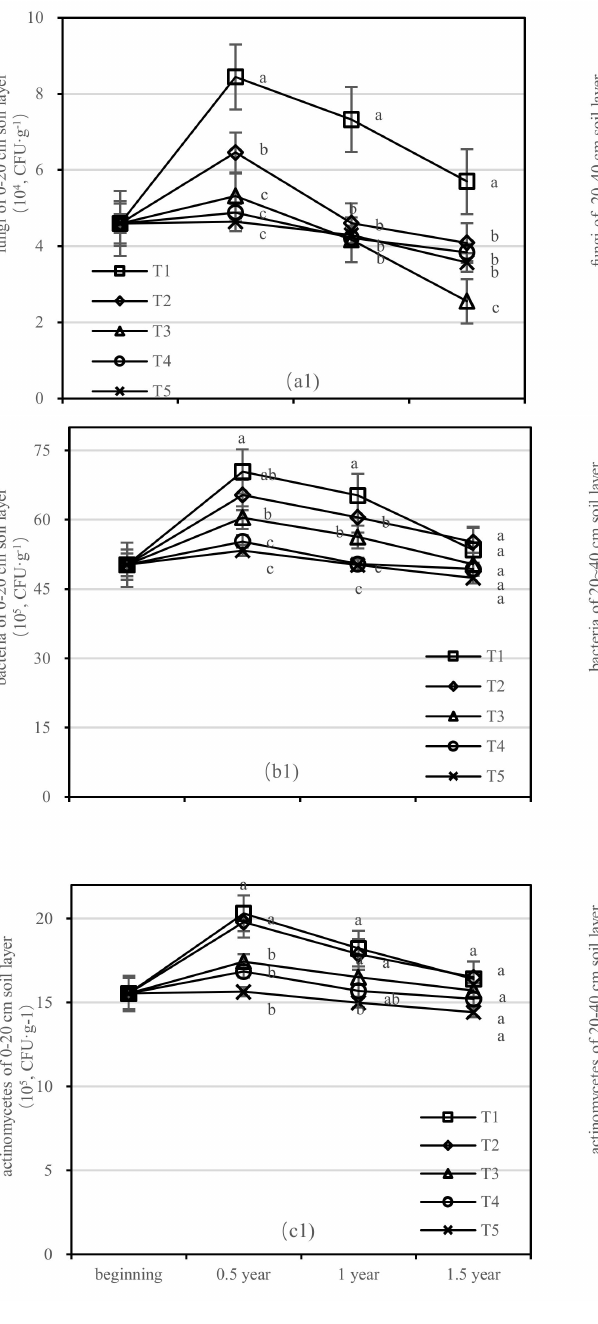
Figure 8. Quantity of soil fungi, bacteria, and actinomycetes in four periods under five fertilization types. Data are the mean content ± standard deviation. Letters represent differences ( α =